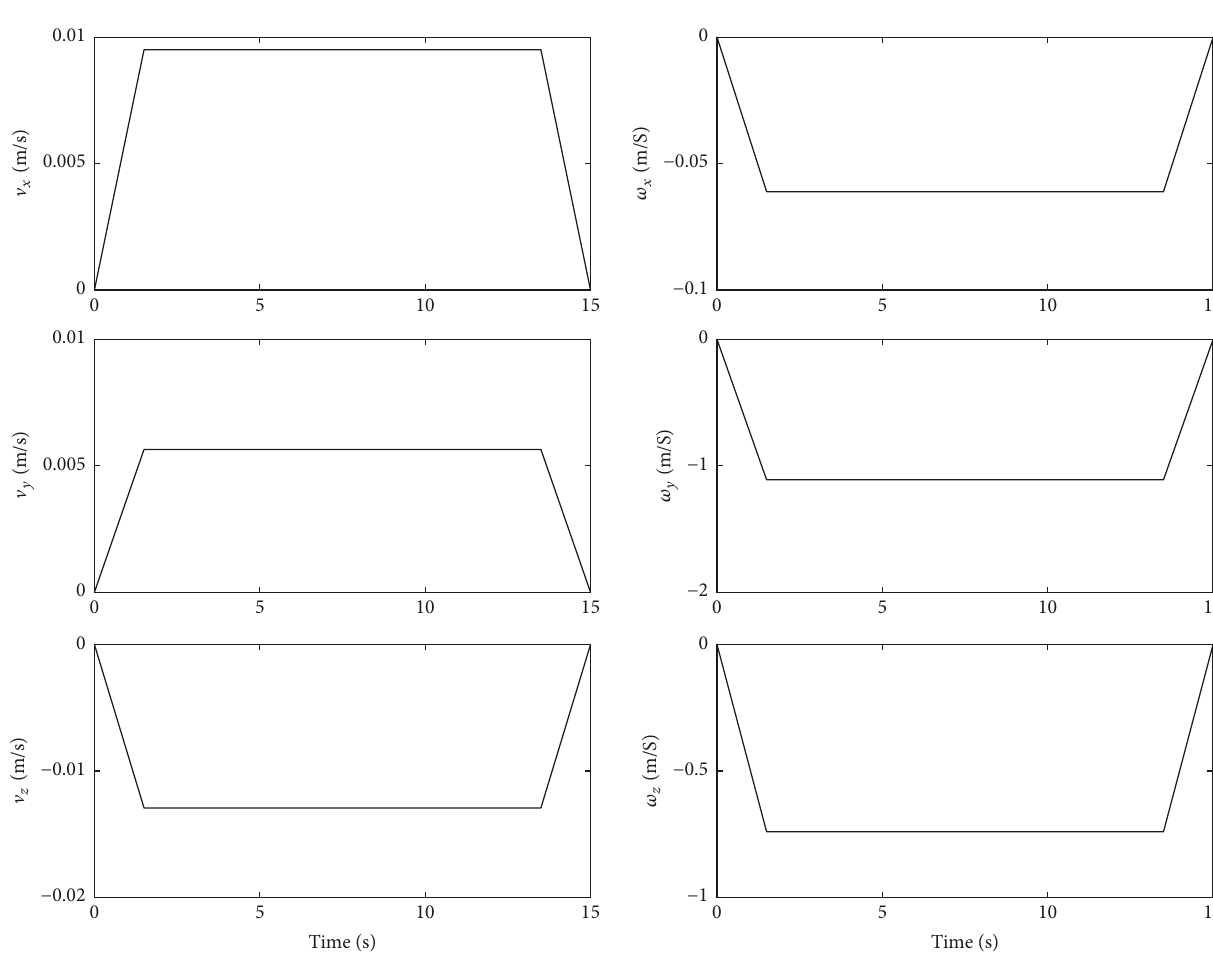
Figure 4: Desired end-effector velocity of space manipulator end-effector.